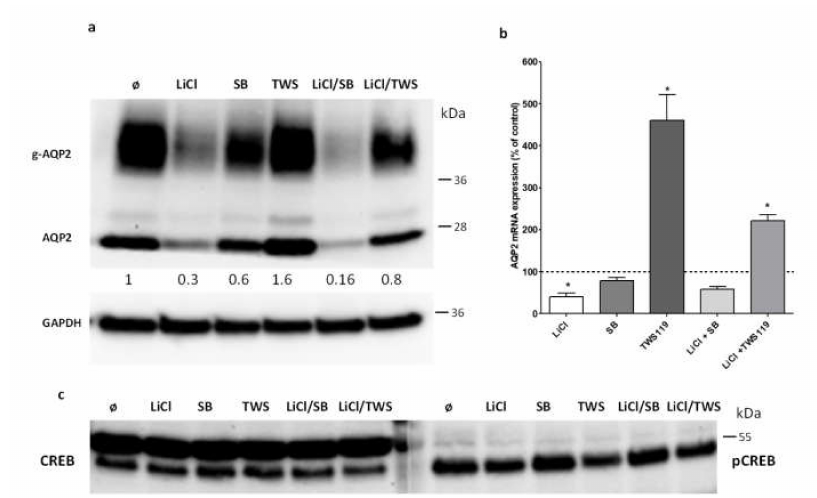
Figure 6. E ff ect of LiCl treatment in combination with GSK3 inhibition on AQP2 expression. The expression of Aqp2 in IMCD cells treated with LiCl (20 mM / 24 h), GSK3 α / β inhibitor SB216763 (SB; 10 µ M / 24 h), GSK3 β TWS119 (TWS; 10 µ M / 24 h), and in combination of LiCl together with SB216763 (LiCl / SB) or LiCl together with TWS119 (LiCl / TWS) was analyzed by Western blot ( a ). Afterwards, the antibodies were stripped, and the membrane was incubated with GAPDH. The numbers indicate the relative Aqp2 signal intensities compared to untreated cells (n = 1). The same setting was used to analyze the Aqp2 mRNA by real-time PCR ( b ). One-way ANOVA analysis with Tukey post-test and * indicates statistically significant di ff erences compared to untreated cells ( p ≤ 0.05); n = 3. Using the same samples as described in ( a ), the expression level of cAMP-response element-binding protein (CREB, c ) left panel) and of the phosphorylated form of CREB (pCREB, c ) right panel) was analyzed by Western